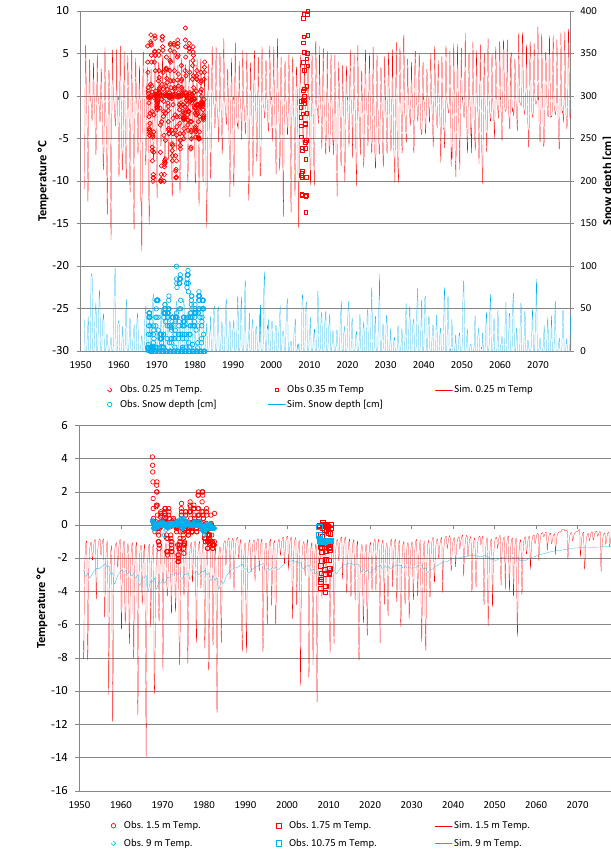
Fig. 7. Observed and simulated snow depth and ground temperature at 0.25m (A) and ground temperatures at 1.5m and 9m (B) near the Sisimiut area for the entire simulation period. The older data from Olesen et al. (2003) and the recent data collected as part of the present study are from different locations in